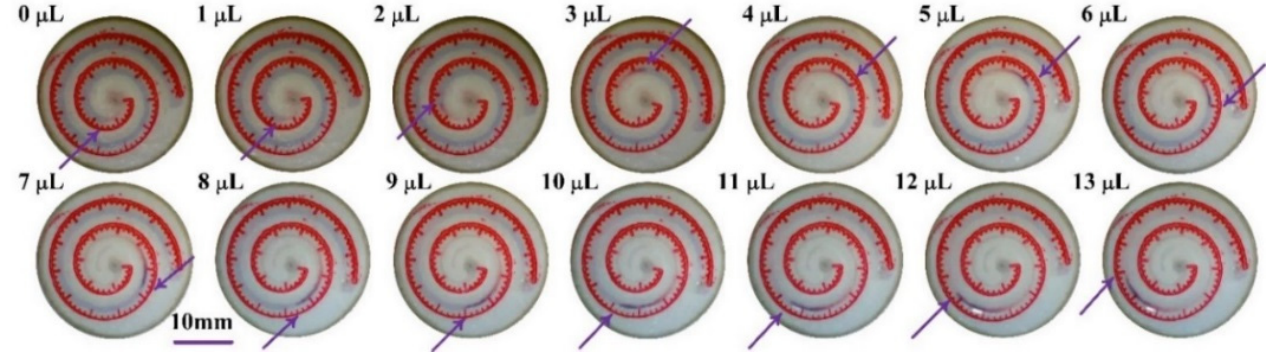
Figure 9. Calibration of a